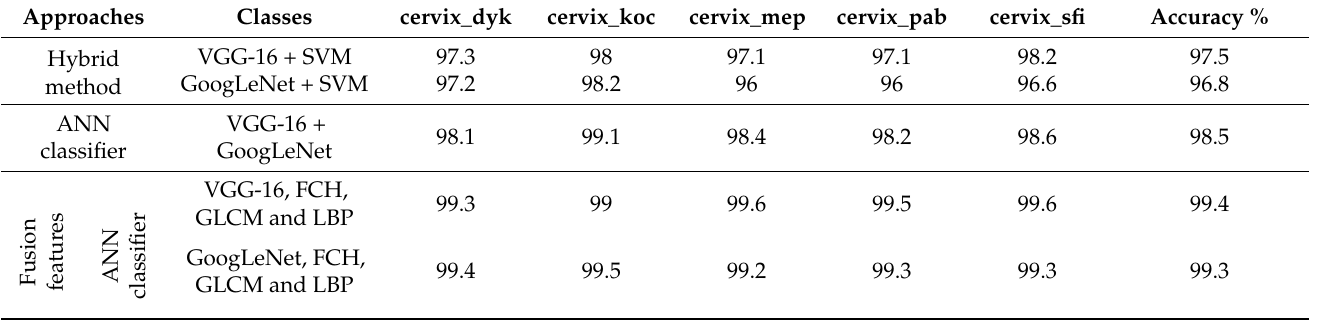
Table 6. Performance of all systems for the diagnosis of five types of abnormal cells of cervical cancer.